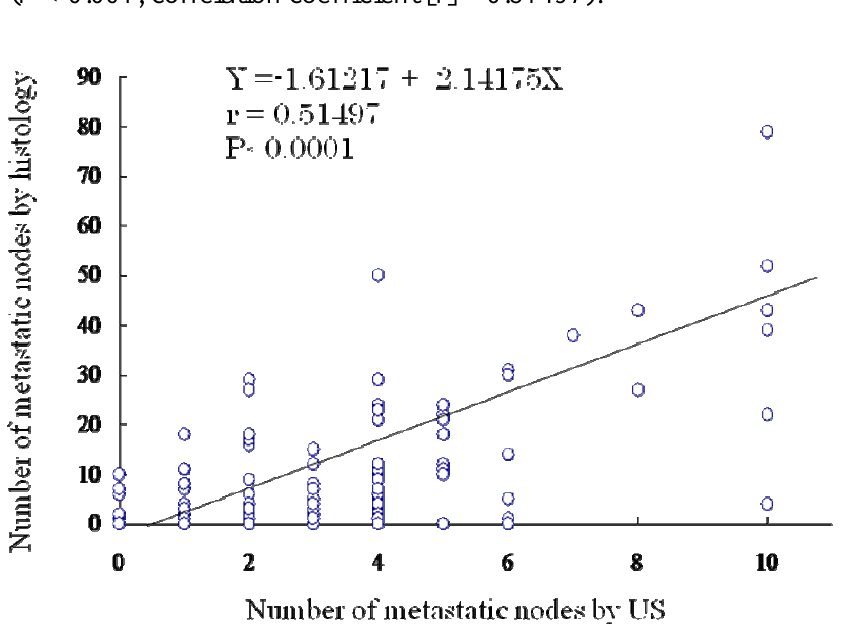
Figure 1. Correlation of the number of lymph node metastases between ultrasound diagnosis and histologic diagnosis. A significant difference using multiple logistic analysis was found (P < 0.001; correlation coefficient [r] = 0.51497).